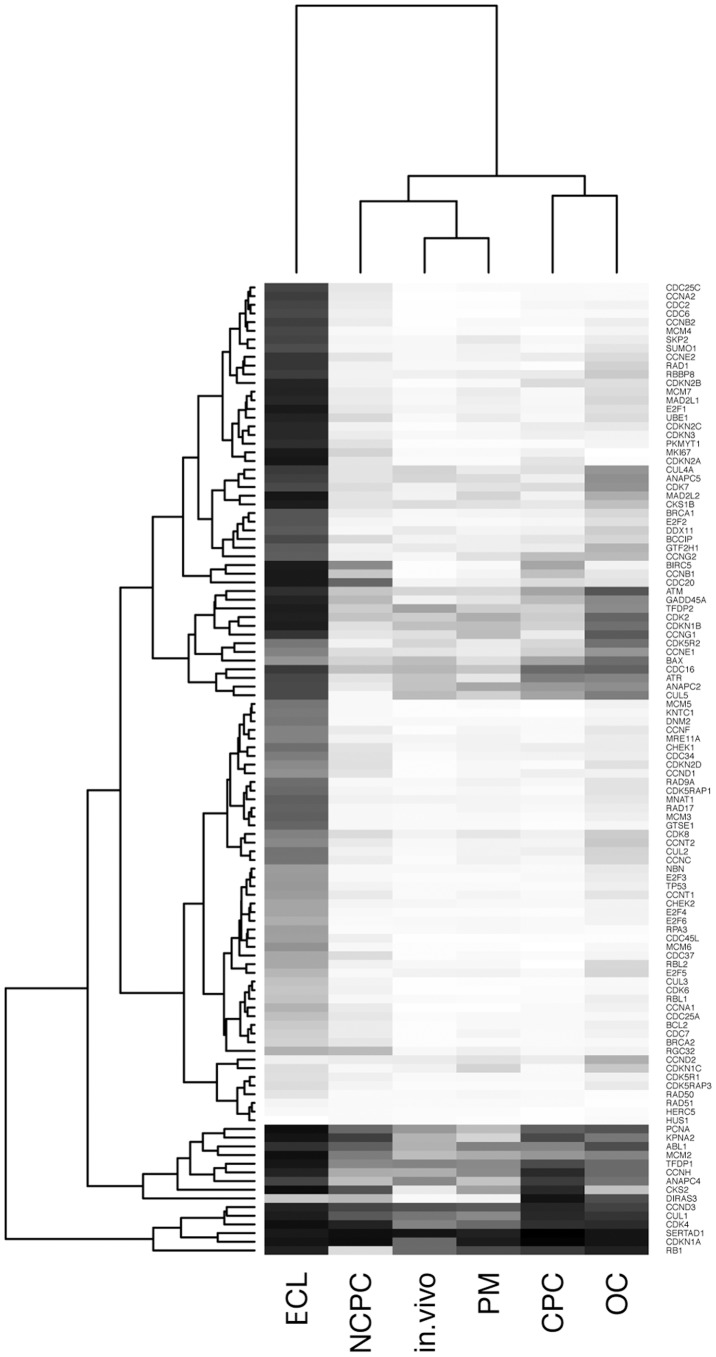
Clustergram analysis of expression of 112 cell cycle genes in endothelial cells of the six different biological models: in vivo, post mortem (PM), organ culture (OC), in vitro confluent primary culture (CPC), in vitro non confluent primary culture (NCPC), and cell line (ECL).Normalized expressions of all models were represented on the heatmap graph. Gray scale from 0 (blank) to 1 (black) represents variation between minimum and maximum normalized values.